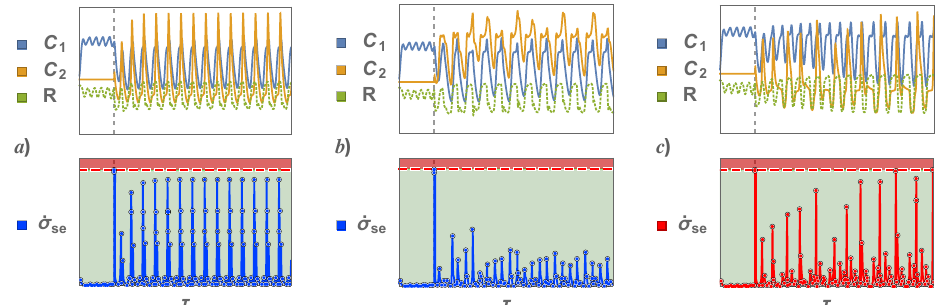
Figure 7. Illustration of the different nature of possible solutions in terms of the populations dynamics (upper panels) and the corresponding social-ecological entropy production (lower panels) of the P-P mode of knowledge-transfer method. ( a ) Sustainable: The post-intervention dynamics has peaks with high entropy production rate after the intervention. The SES can be considered sustainable but fragile, since an unexpected perturbation may induce the dynamics to cross the entropy production rate threshold. ( b ) Sustainable: The post-intervention dynamics shows an irregular dynamics which is more manifest through the entropy production rate. The long-time behavior seems to decrease the entropy production maintaining the SES with an irregular but sustainable dynamics. ( c ) Catastrophic: After the intervention, the entropy production rate shows oscillations with increasing amplitude that eventually cross the entropy production rate threshold, indicating that the SES unsustainable. See the main text for a detailed discussion of the results. The figure is own creation.